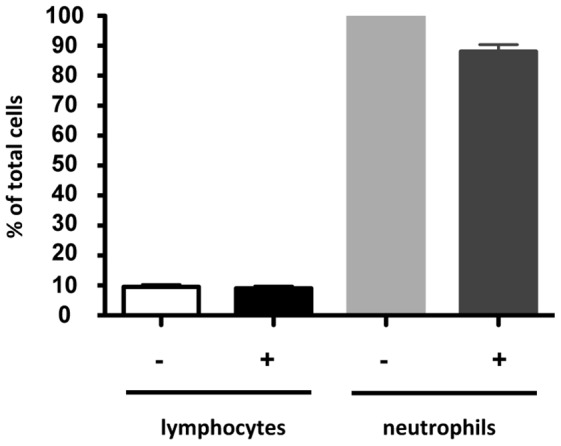
Live Mf presence does not alter chemotaxis of lymphocytes and neutrophils.HUVEC were co-cultured with or without live Mf in the lower well of a transmigration assay plate. After 24 hours, PBMC or granulocytes were added in the inserts. After a further 4 hours leukocytes attracted into the lower wells were analysed using flow cytometry. Data is shown as the mean and standard deviation of an experimental triplicate.